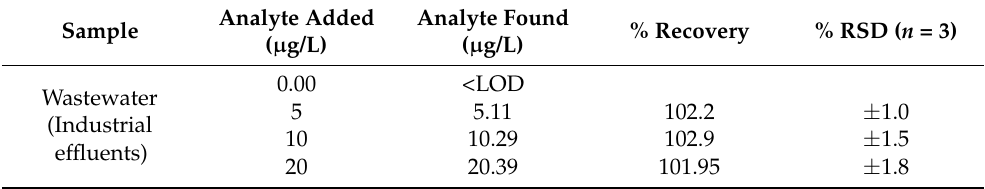
Table 1. Application of the method for NR in wastewater (industrial effluents).